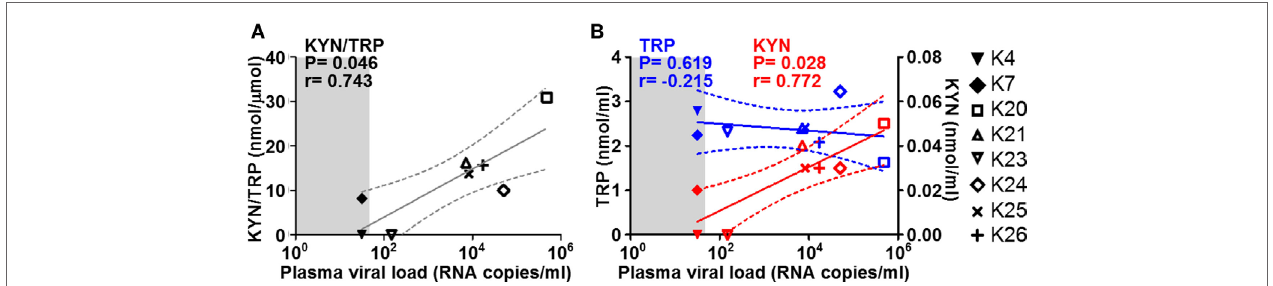
FigUre 4 | cerebrospinal fluid (csF) KYn and TrP in relation to plasma viremia . Scatter plots showing the correlations (non-parametric Spearman test) between plasma viremia at the time of necropsy ( x axes) and (a) KYN/TRP ratios, (B) KYN (red), and TRP (blue) levels in the CSF. Solid lines show the projected linear regressions, and dotted lines show the 95% confidence intervals. Shaded areas indicate the range of undetectable viremia ( < 50 RNA copies/ml).